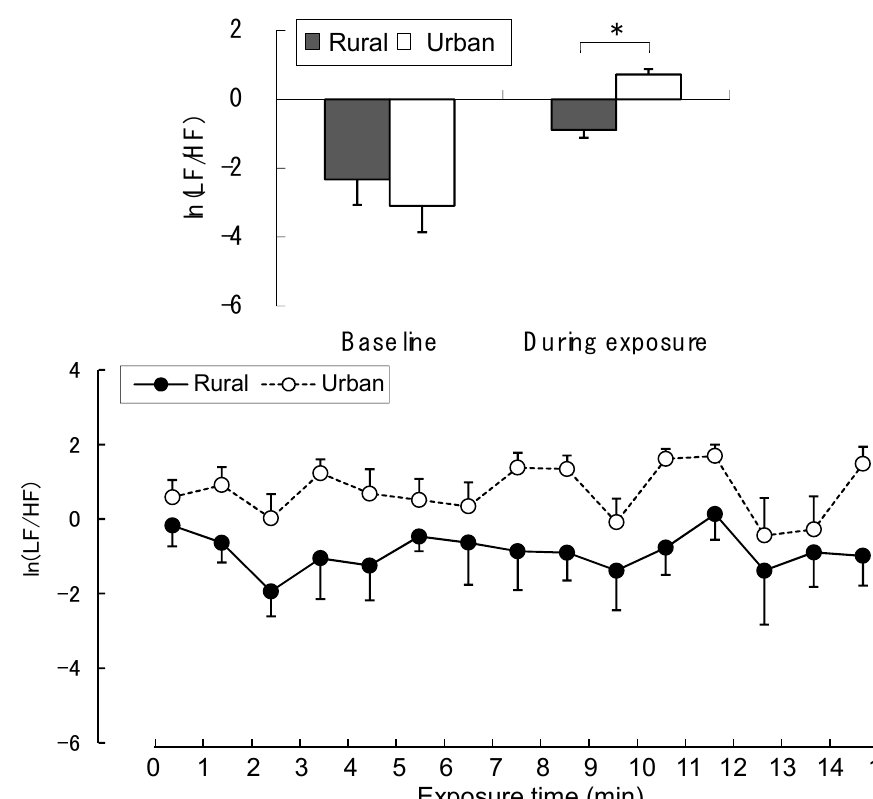
Figure 5. Comparison of the natural logarithm of high frequency/low frequency ratio in heart rate variability between rural and urban exposures (top) and of 1-min fluctuations of the value (bottom) during exposure. Mean ± SE; N = 11; * p < 0.05; paired t